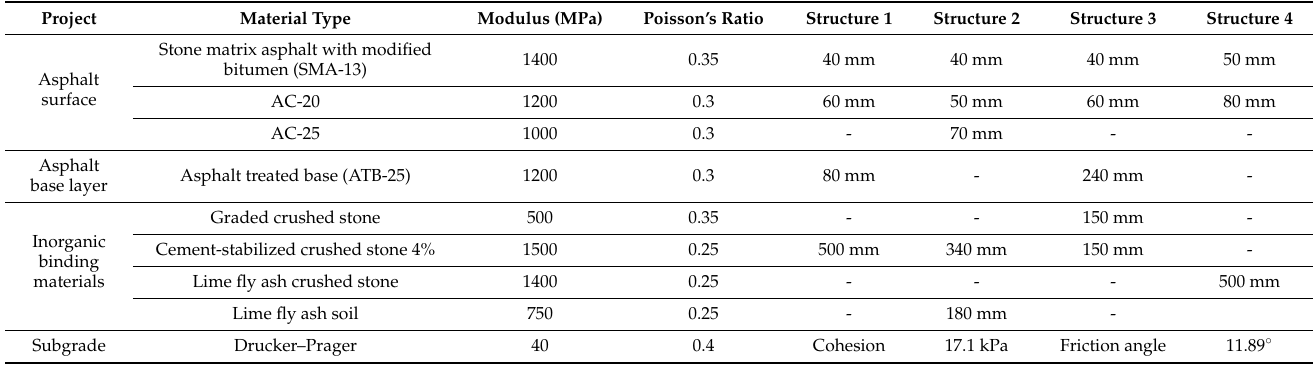
Table 10. Pavement structure layer thickness and material composition.